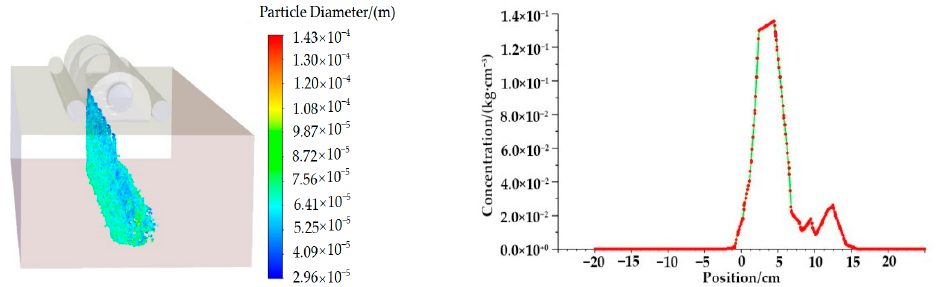
Figure 16. Droplet spatial distribution and the droplet concentration in the calibration line.